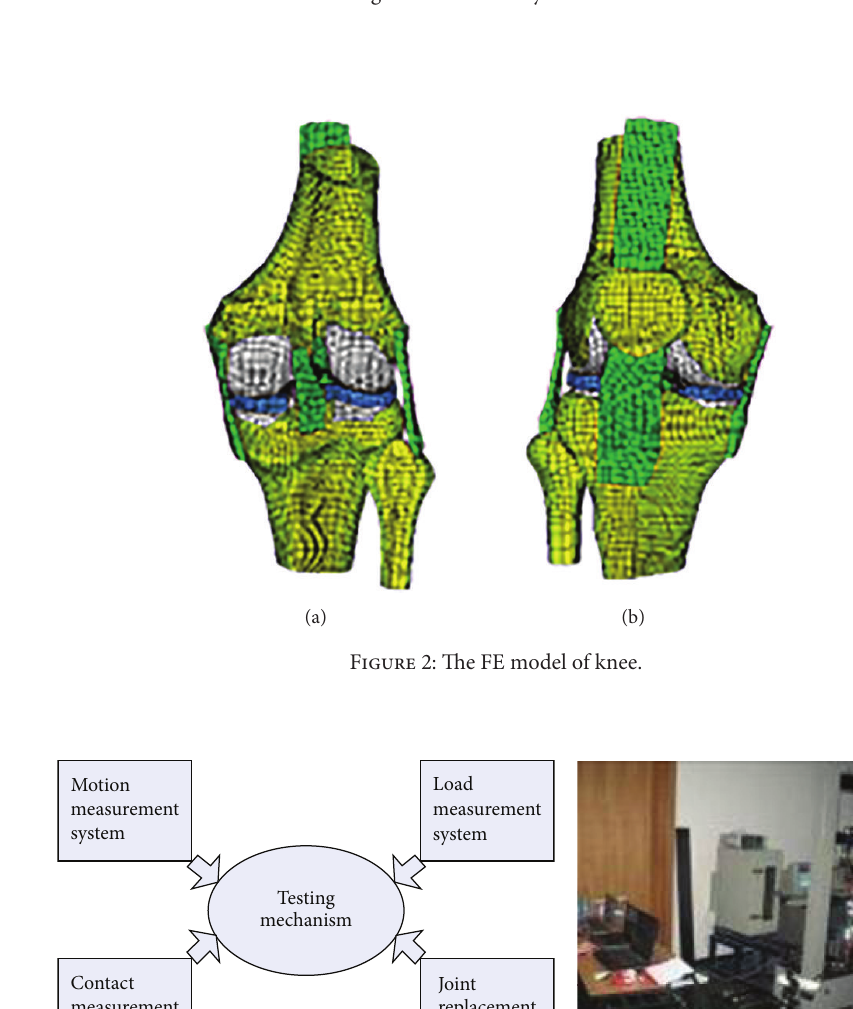
Figure 1: The geometric anatomy model of human knee.